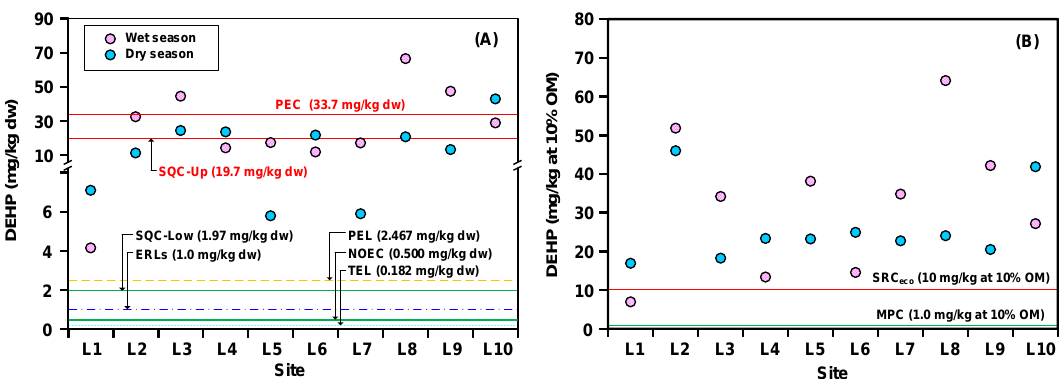
Figure 4. Comparison of the ( A ) original and ( B ) 10% OM-adjusted DEHP concentrations with sediment quality guidelines (SQLs) at 10 monitoring sites during the dry season and the wet season. ERLs, environmental risk limits; PEL, probable effect level; NOEC, no observed effect concentration; TEL, threshold effect level; SRC eco , ecotoxicological serious risk concentrations; MPC, maximum permissible concentration.